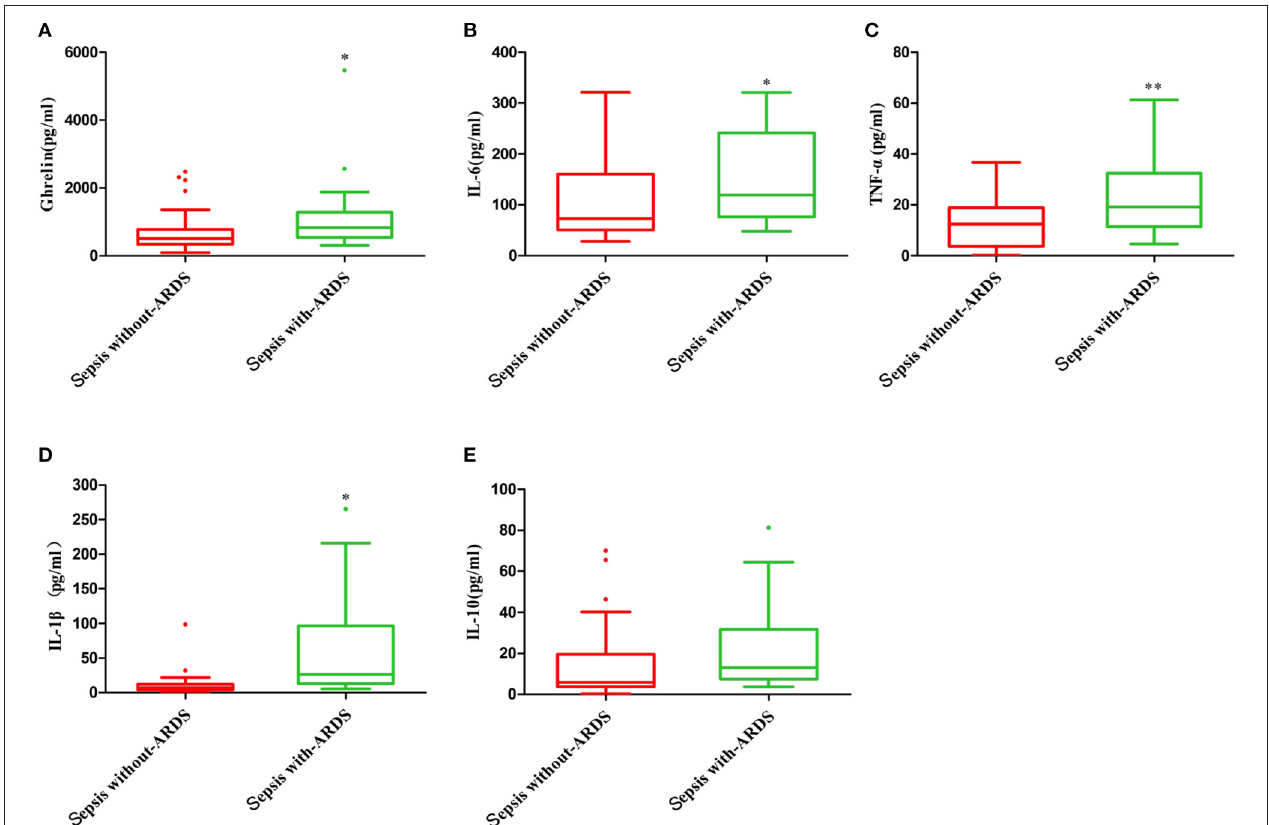
FIGURE 2 | Plasma ghrelin level and concentration of inflammatory factors in sepsis with and without ARDS. (A) ghrelin, (B) IL-6, (C) TNF- α , (D) IL-1 β , and (E) IL-10. * p < 0.05; ** p < 0.001.